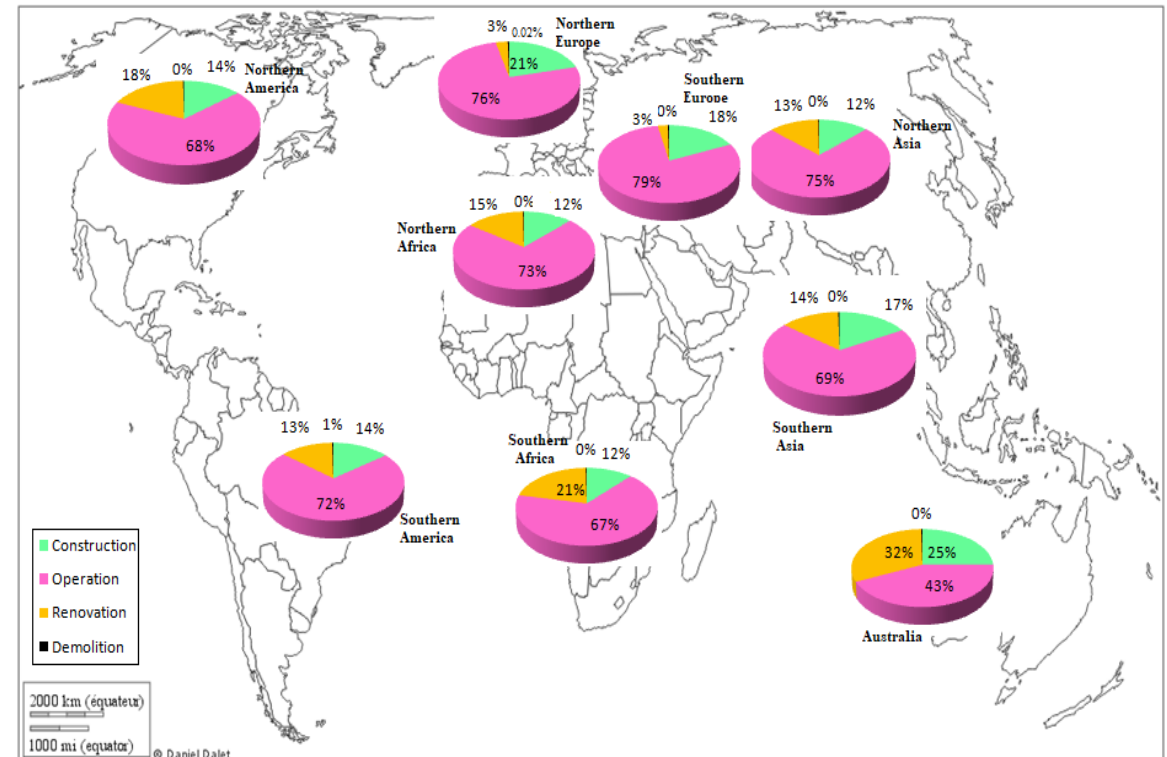
Figure 1. Distribution of acidification potential frequency of different phases of the sustainable neighborhood in several world regions.